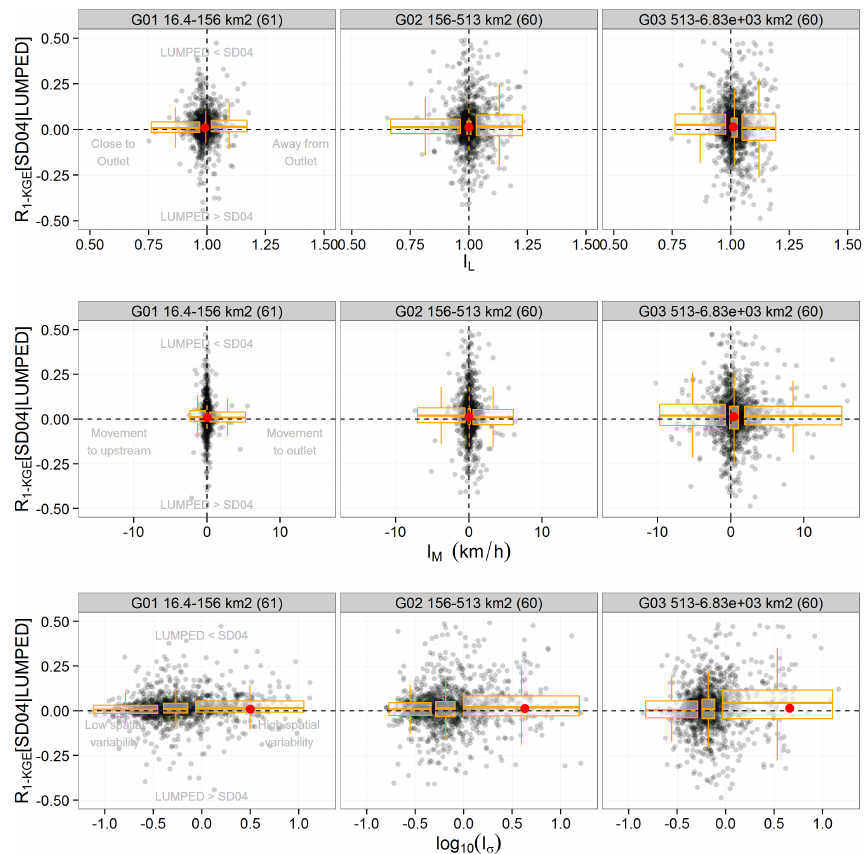
Fig. 11. Relative KGE performance index in validation mode between the lumped and the semidistributed (SD04) simulations. The relative performance indexes are computed for 3620 flood events ordered by location index (top panels), rainfall movement index (middle panels), spatial rainfall variability index (bottom panels) and for three groups of 60 catchments classed by area (G01, G02, and G03). For each catchment group, the red point plotted on the x axis at x =0 shows the median values of the variable of interest ( I L , I M or I σ ). The box plots show the distribution of the relative KGE performance index for three groups of events with the same number of events per box plot.